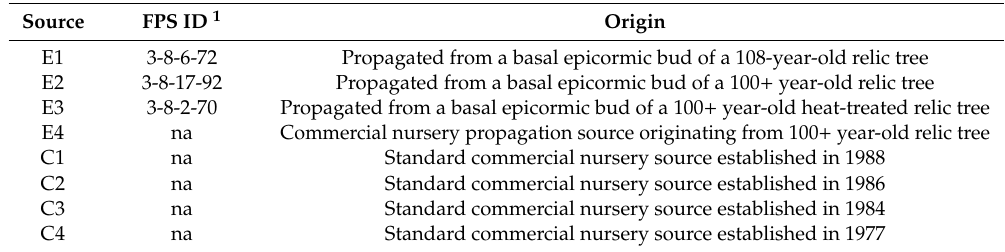
Table 2. Nonpareil almond propagation